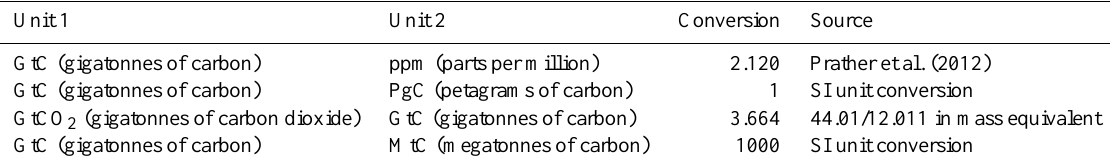
Table 1. Factors used to convert carbon in various units (by convention, Unit1 = Unit2 · conversion).